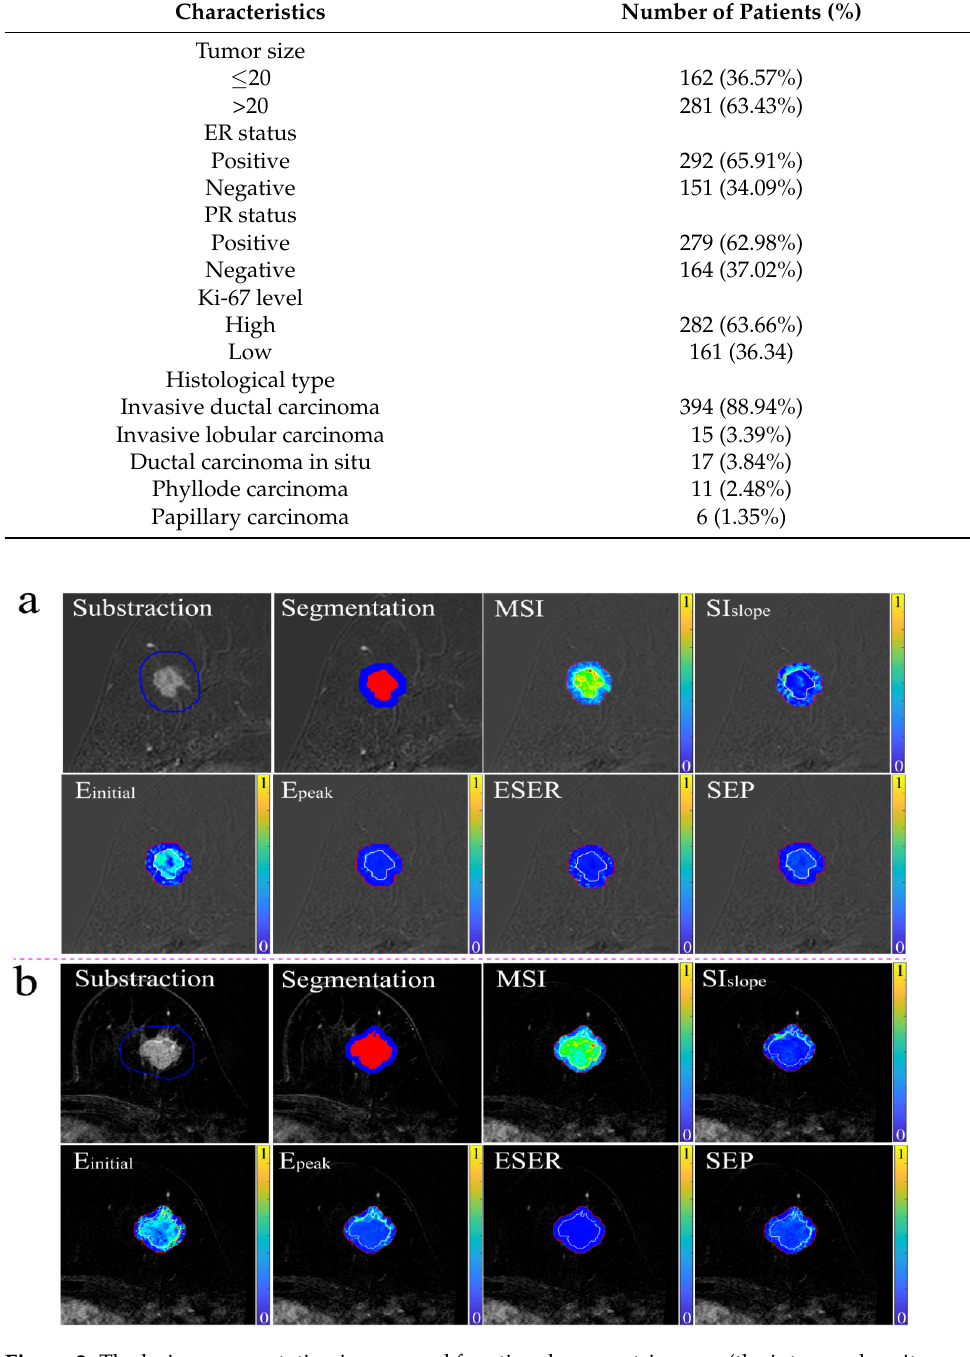
Figure 2. The lesion segmentation images and functional parametric maps (the intra- and peritumoral margins were marked using white and red lines) of two randomly selected cases. ( a ) The images of positive ER and PR status in BC. ( b ) The images of negative ER and PR status in BC.